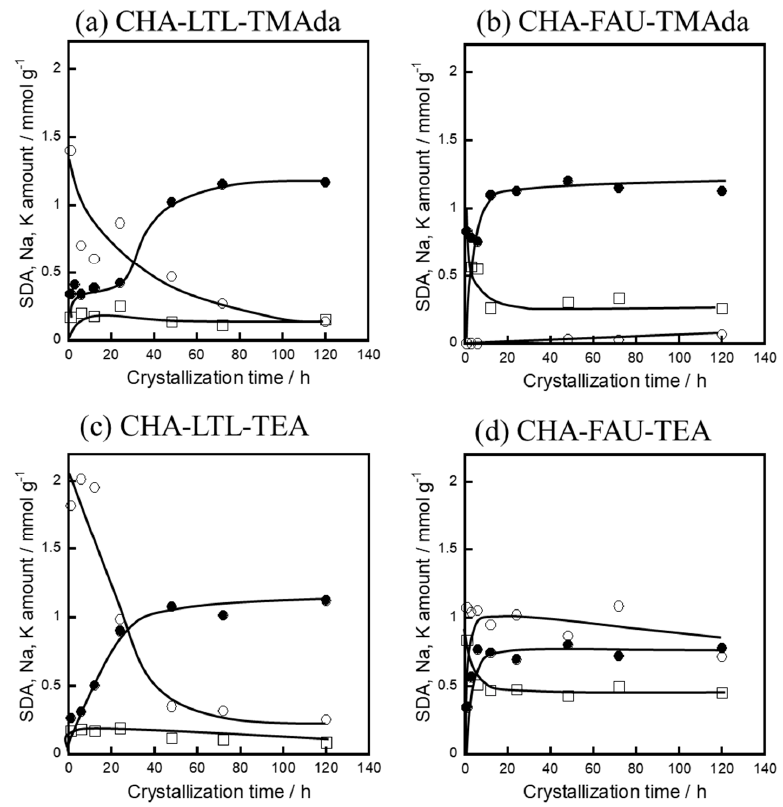
Figure 5. Relationship between crystallization time and SDA / Al. ( a ) CHA–LTL–TMAda, ( b ) CHA–FAU–TMAda, ( c ) CHA–LTL–TEA, ( d ) CHA–FAU–TEA ( □ : Na + , ○ : K + , ● : OSDA).